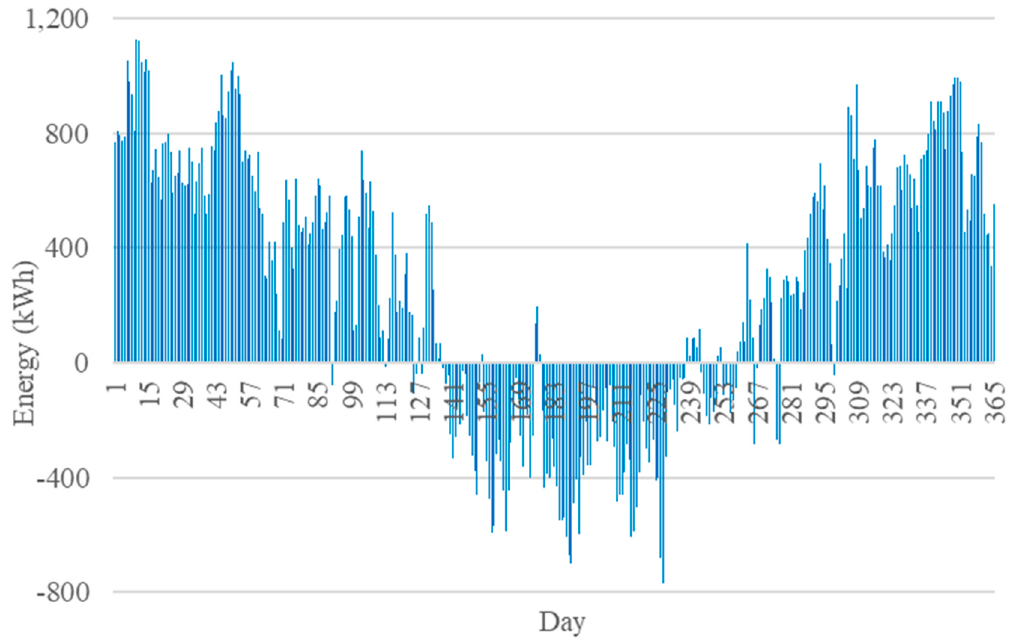
Figure 12. Distribution of daily space heating demand in the considered micro housing estate.